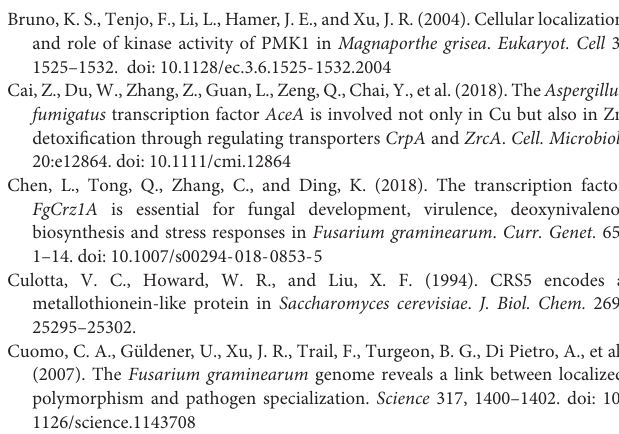
FIGURE S1 | Bioinformatic analysis of putative Cu detoxification determinants. FIGURE S2 | Diagram for generation and verification for (cid:77) FgAceA by Southern blotting analysis. FIGURE S3 | Diagram for generation and verification for (cid:49) FgCrpA by Southern blotting analysis. FIGURE S4 | Diagram for generation and verification for (cid:77) FgCrdA by Southern blotting analysis. FIGURE S5 | Diagram for generation and verification for OE:FgCrpA by Southern blotting analysis. TABLE S1 | PCR primers used in this study. TABLE S2 | Expression of genes encoding putative copper-binding proteins revealed by